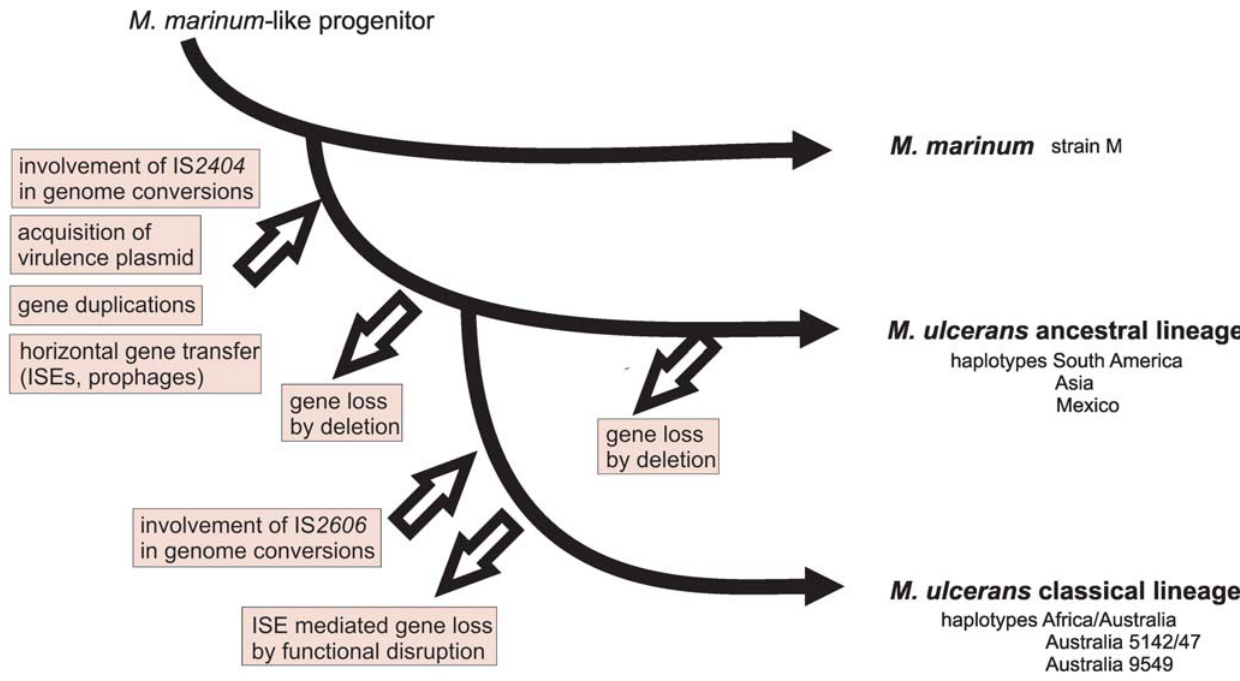
Figure 5. Genomic events leading to strain variations and pathogen emergence in M.ulcerans haplotypes.